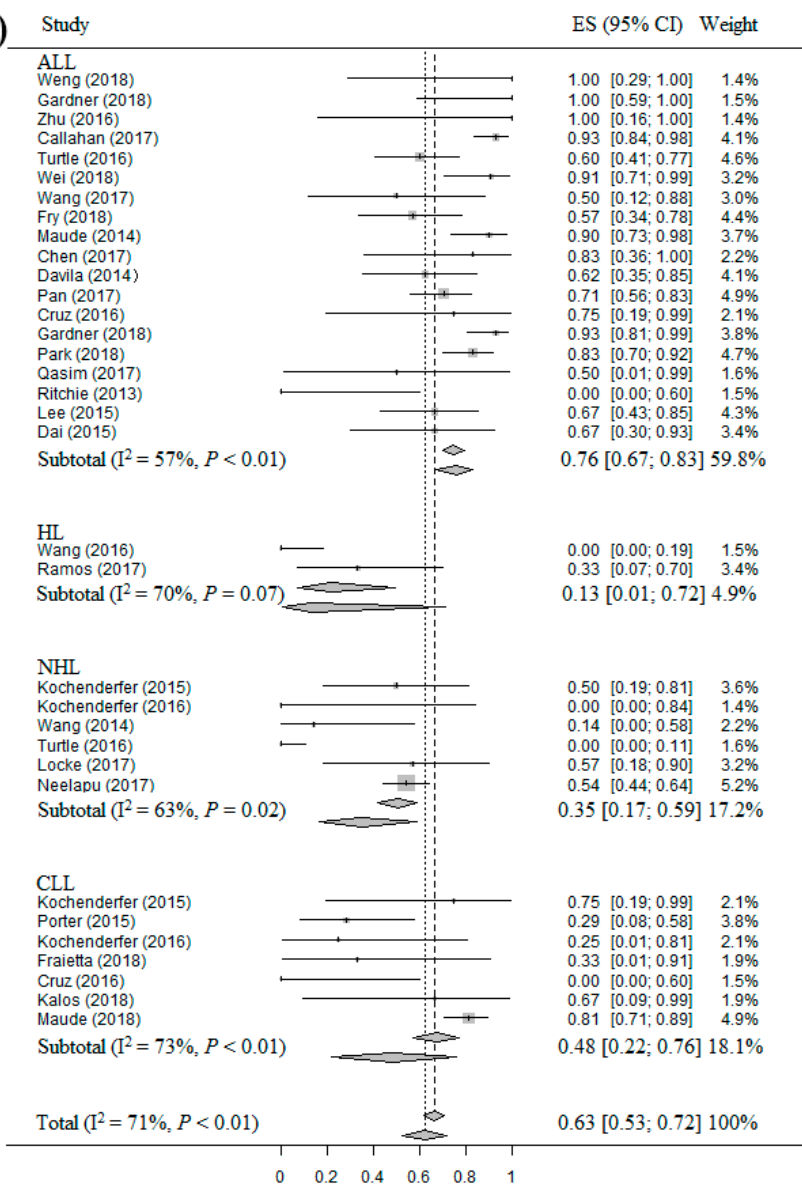
Figure 3 . The forest plots of meta-analysis about CRR: ( a ) Forest plot for CRR and CI in solid and hematologic malignancies patients of each study and the overall; ( b ) Forest plot for CRR and CI in different B-cell malignancies patients of each study and the overall.